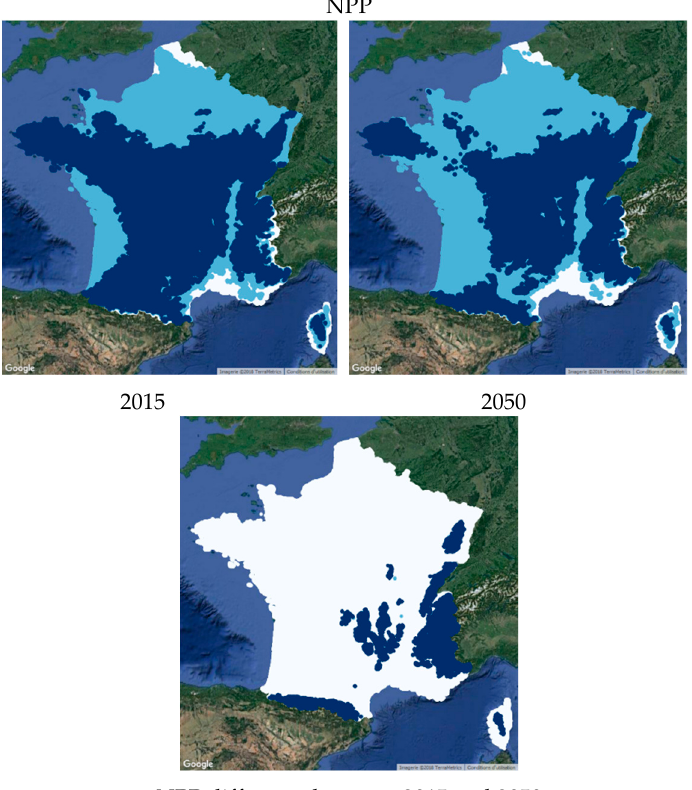
Figure 5. Maps of NPP estimated for 2015 and for 2050 (in white: Low values; in light blue: Average values; in dark blue: High values), and map of the difference of NPP (2050-2015: In white: Decrease of NPP; in blue: Increase of NPP).